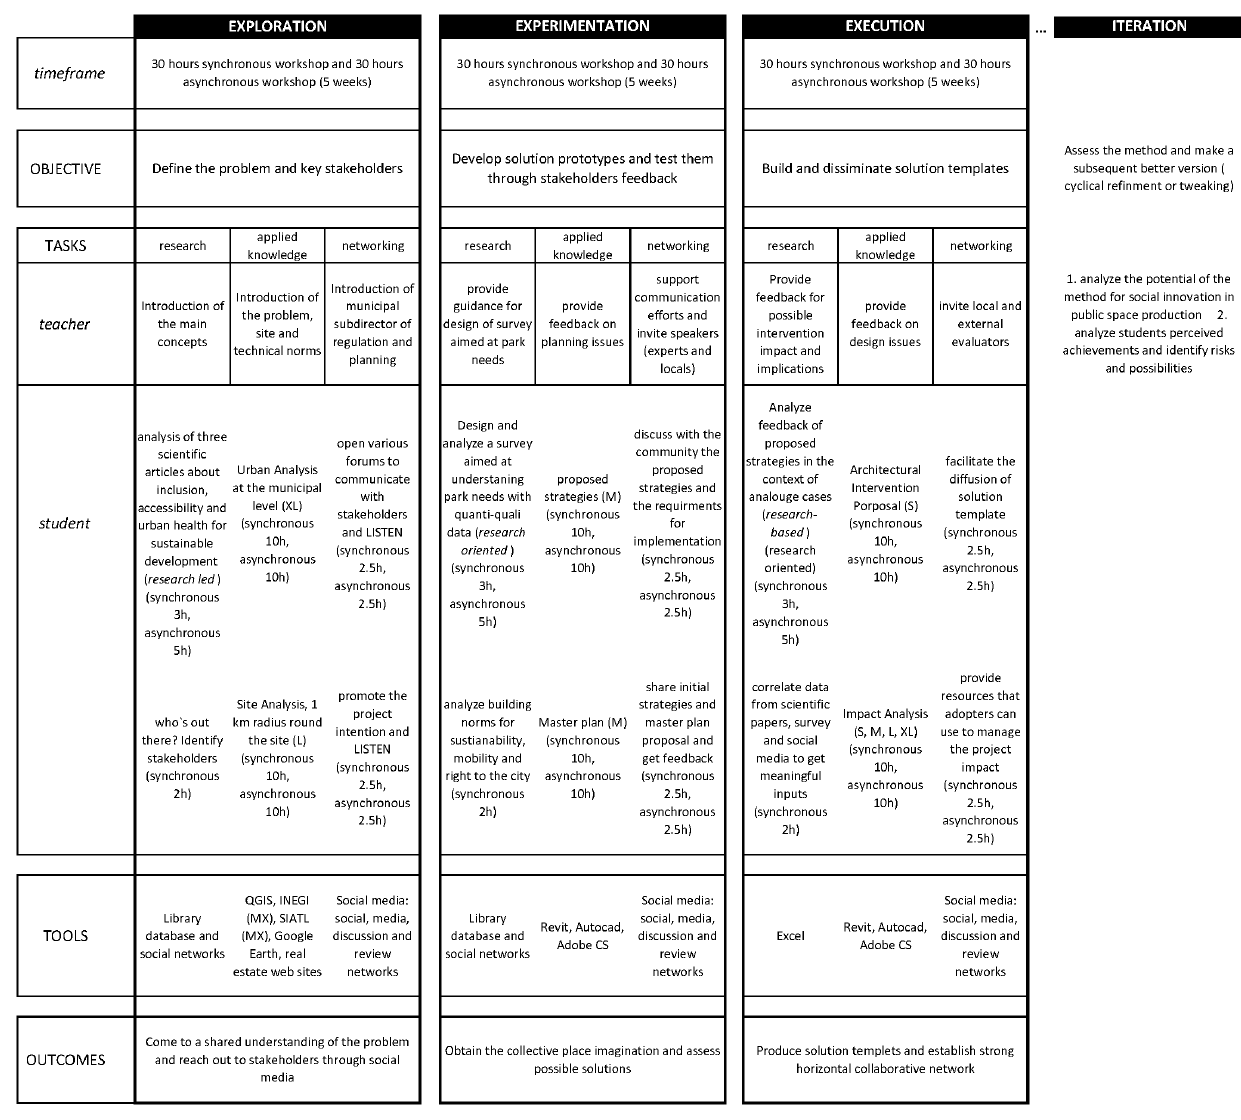
Figure 2. The collaborative educational method for the collective imagination of public space, based on social innovation platforms.